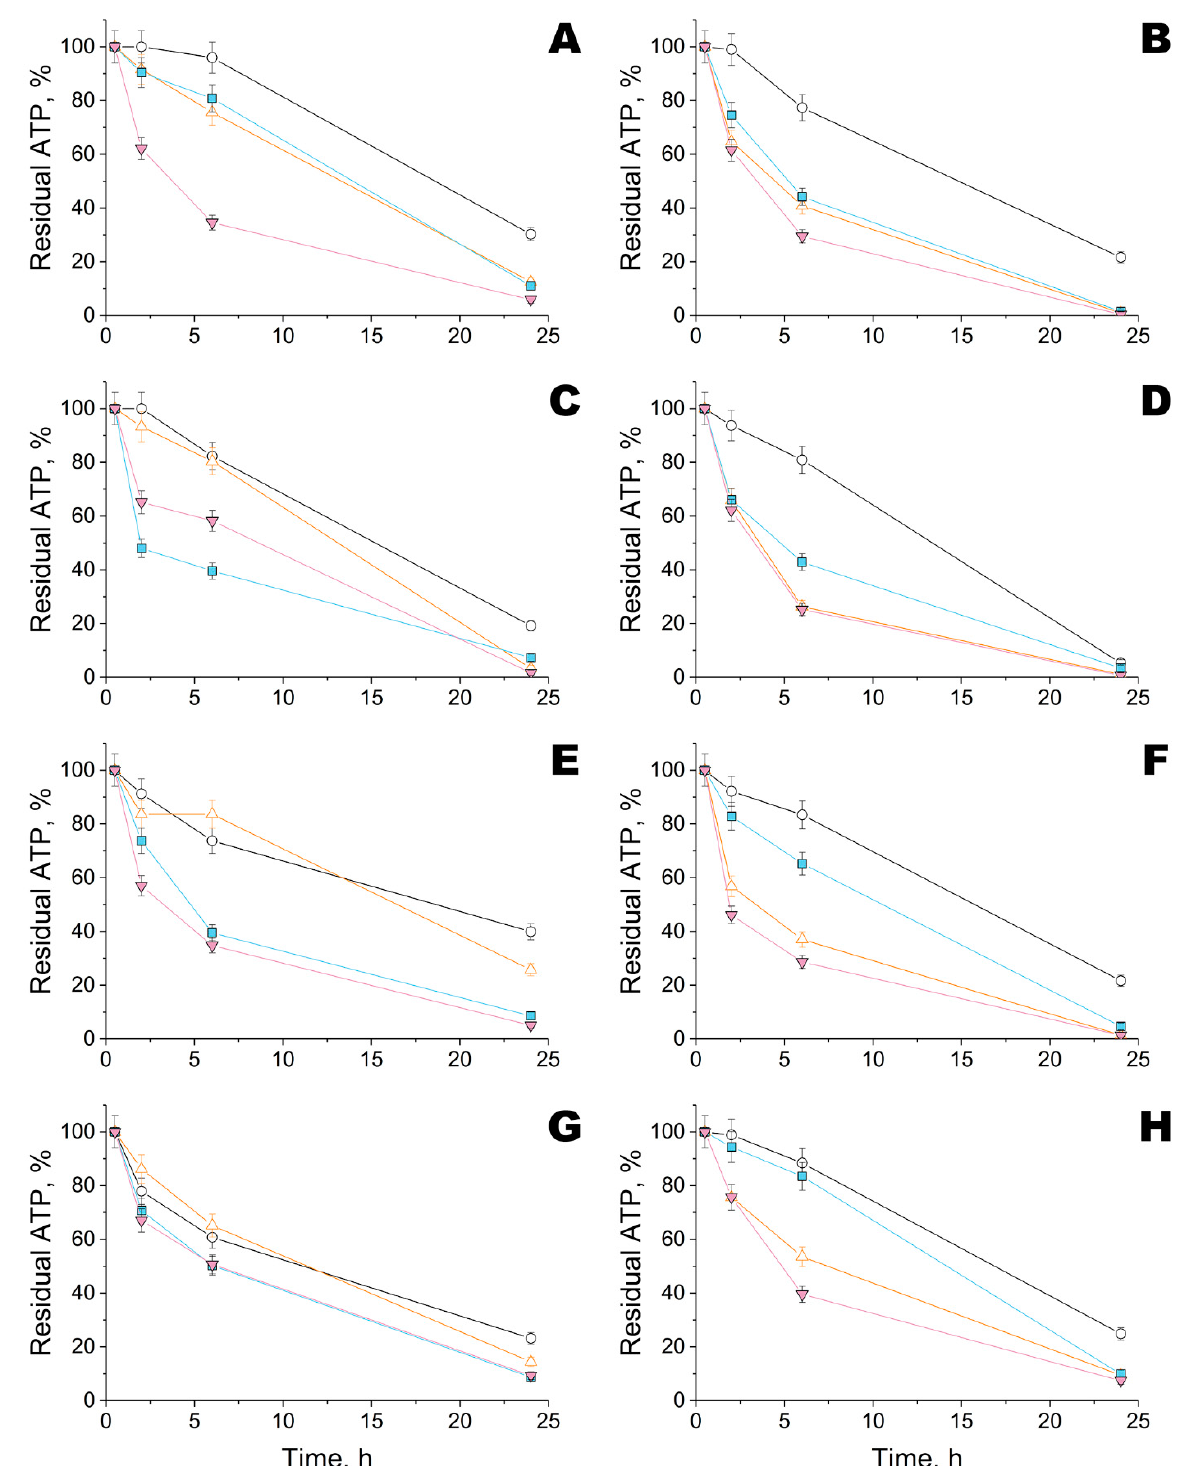
Figure 4. Kinetics of residual intracellular ATP quantity in B. subtilis ( A , C , E , G ) and E. coli bacterial cells ( B , D , F , H ) during their exposure on different fiber materials #1 ( A , B ), #2 ( C , D ), #3 ( E , F ) and #4 ( G , H ) treated with Ta NPs, enzyme His 6 -OPH, or their combinations. ATP quantity in bacterial cells at 0.5 h was taken as 100%. The His 6 -OPH was prepared as a complex with PEG-PLE 50 in a Na-carbonate buffer (pH 10.5). Designation: ○ —control, ■ —Ta NPs, ∆ —His 6 -OPH, ▼— Ta NPs with His 6 -OPH.